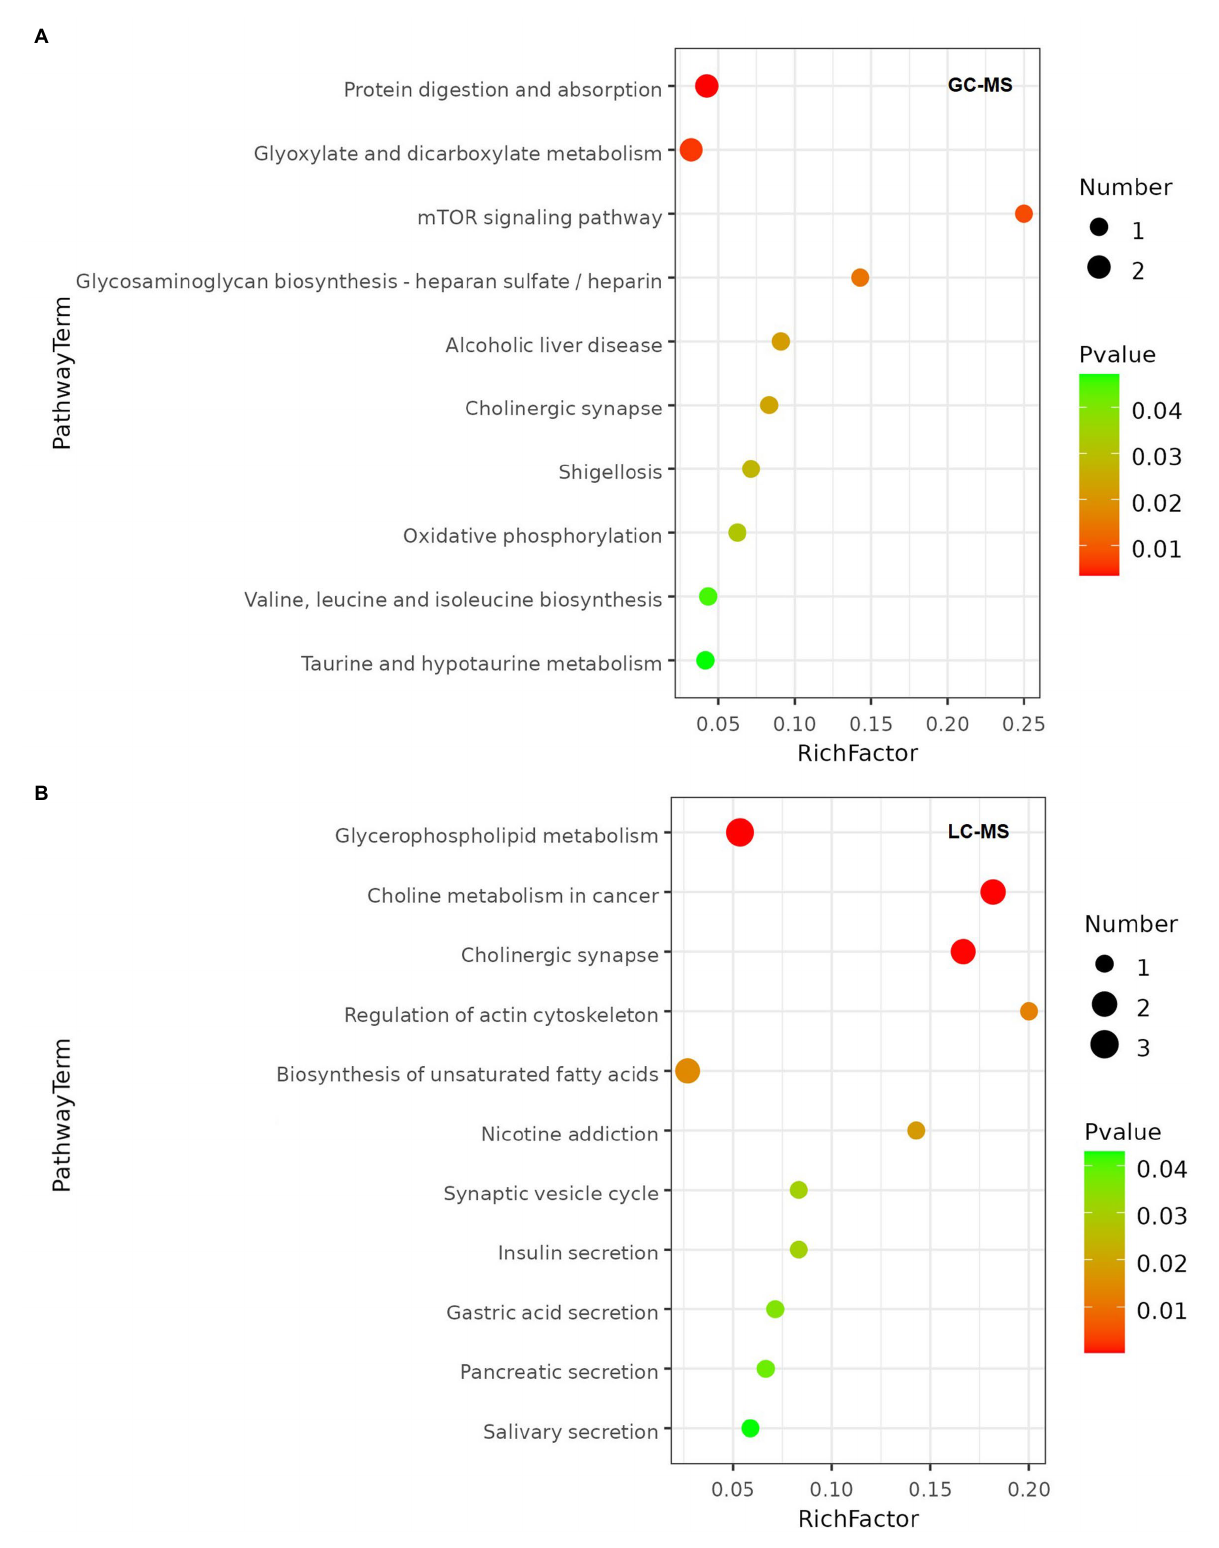
FIGURE 6 Metabolic pathway enrichment bubble chart. The value of p of the metabolic pathway is the significance of the enrichment of the metabolic pathway, and the significant enrichment pathway was selected for bubble plotting. The vertical coordinate is the name of the metabolic pathway; the horizontal coordinate is the enrichment factor (Rich factor = number of significantly differential metabolites/total number of metabolites in the pathway), the larger the Rich factor, the greater the enrichment; the colour from green to red indicates that the value of p decreases; the larger the bubble, the greater the number of metabolites enriched to that pathway. (A) Metabolic pathway enrichment of GC-MS platform. (B) Metabolic pathway enrichment of LC-MS